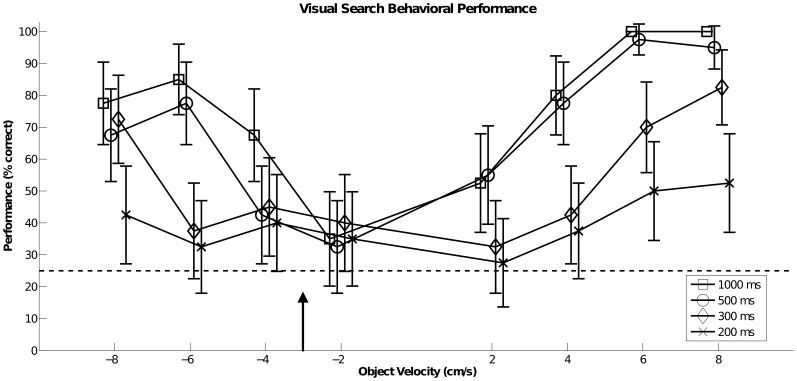
Visual Search (VS) behavioral performance as a function of absolute object velocity over varying stimulus motion durations (1000, 500, 300, 200) milliseconds.X-axis represents relative object velocity (cm/s) and y-axis represents performance (% correct). Error bars represent the 95 percentile confidence interval of the mean performance value. Dotted line at 25% indicates chance level. Arrow indicates observer motion velocity relative to objects (−3 cm/s). The difference between observer speed and object velocity is the relative object velocity shown in the display.